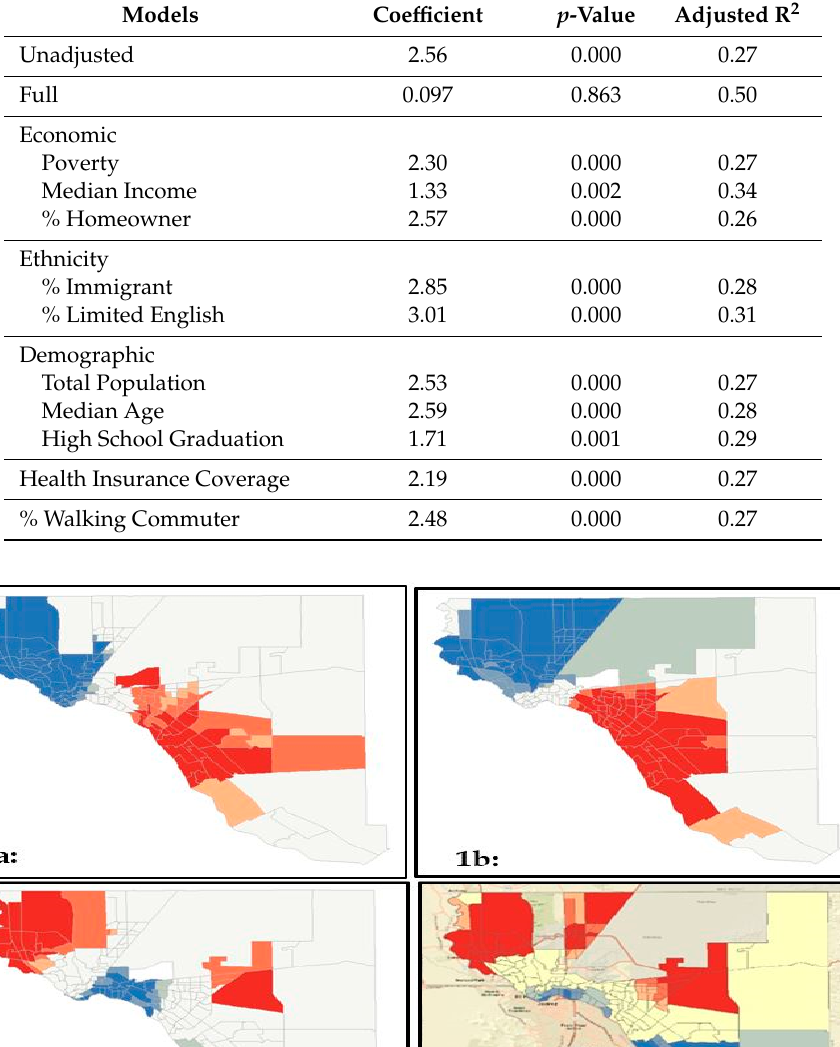
Table 1. Geographically weighted regression results for the census tract obesity prevalence.